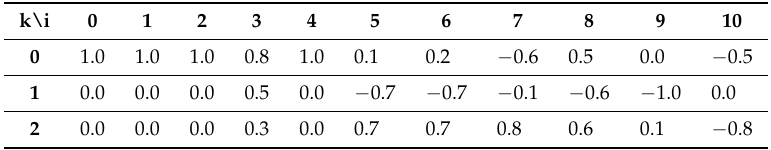
Table A4. α 2 ki